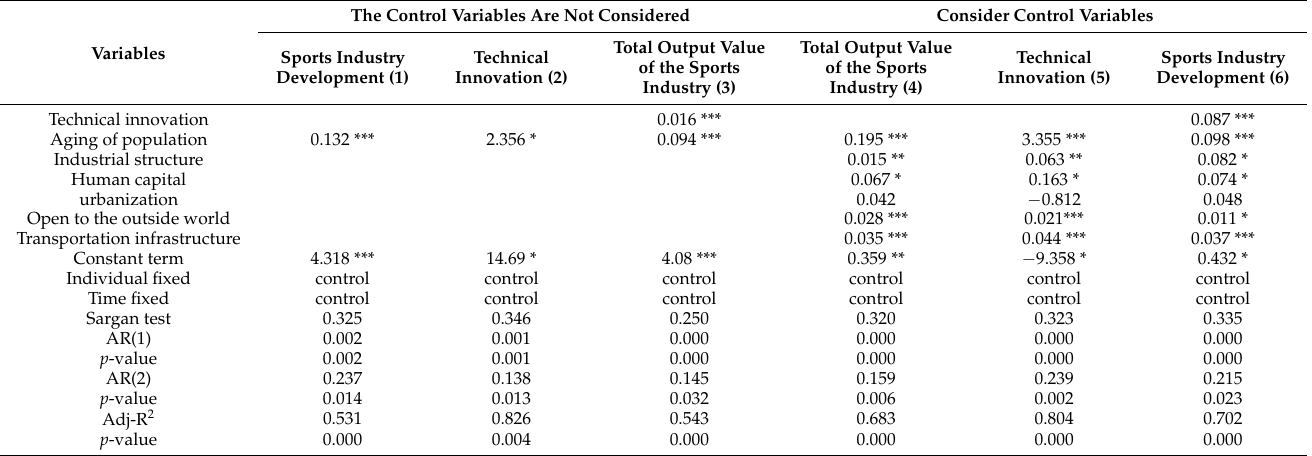
Table 3. Impact of population aging on the total output value of the sports industry through the technological innovation intermediary